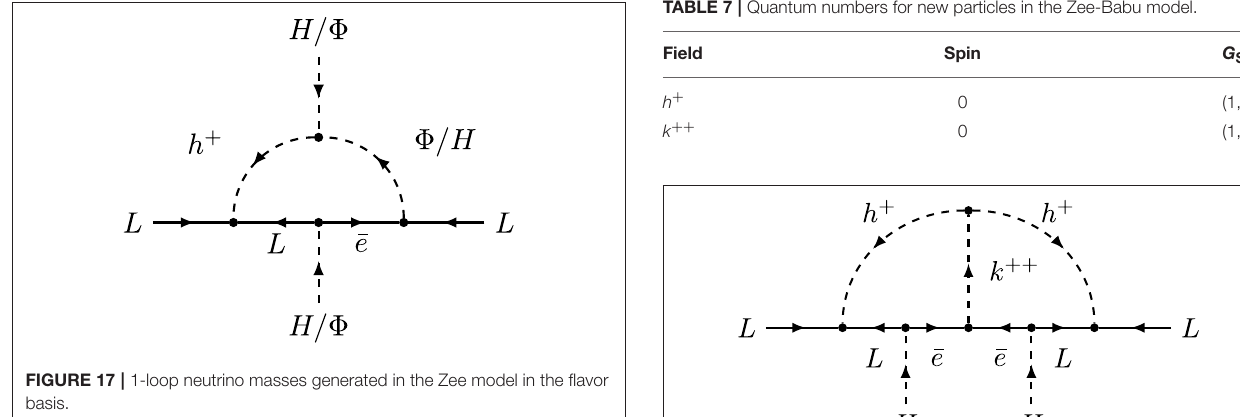
TABLE 7 | Quantum numbers for new particles in the Zee-Babu model.